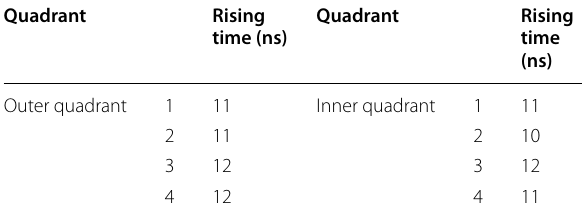
Quadrant time (ns)